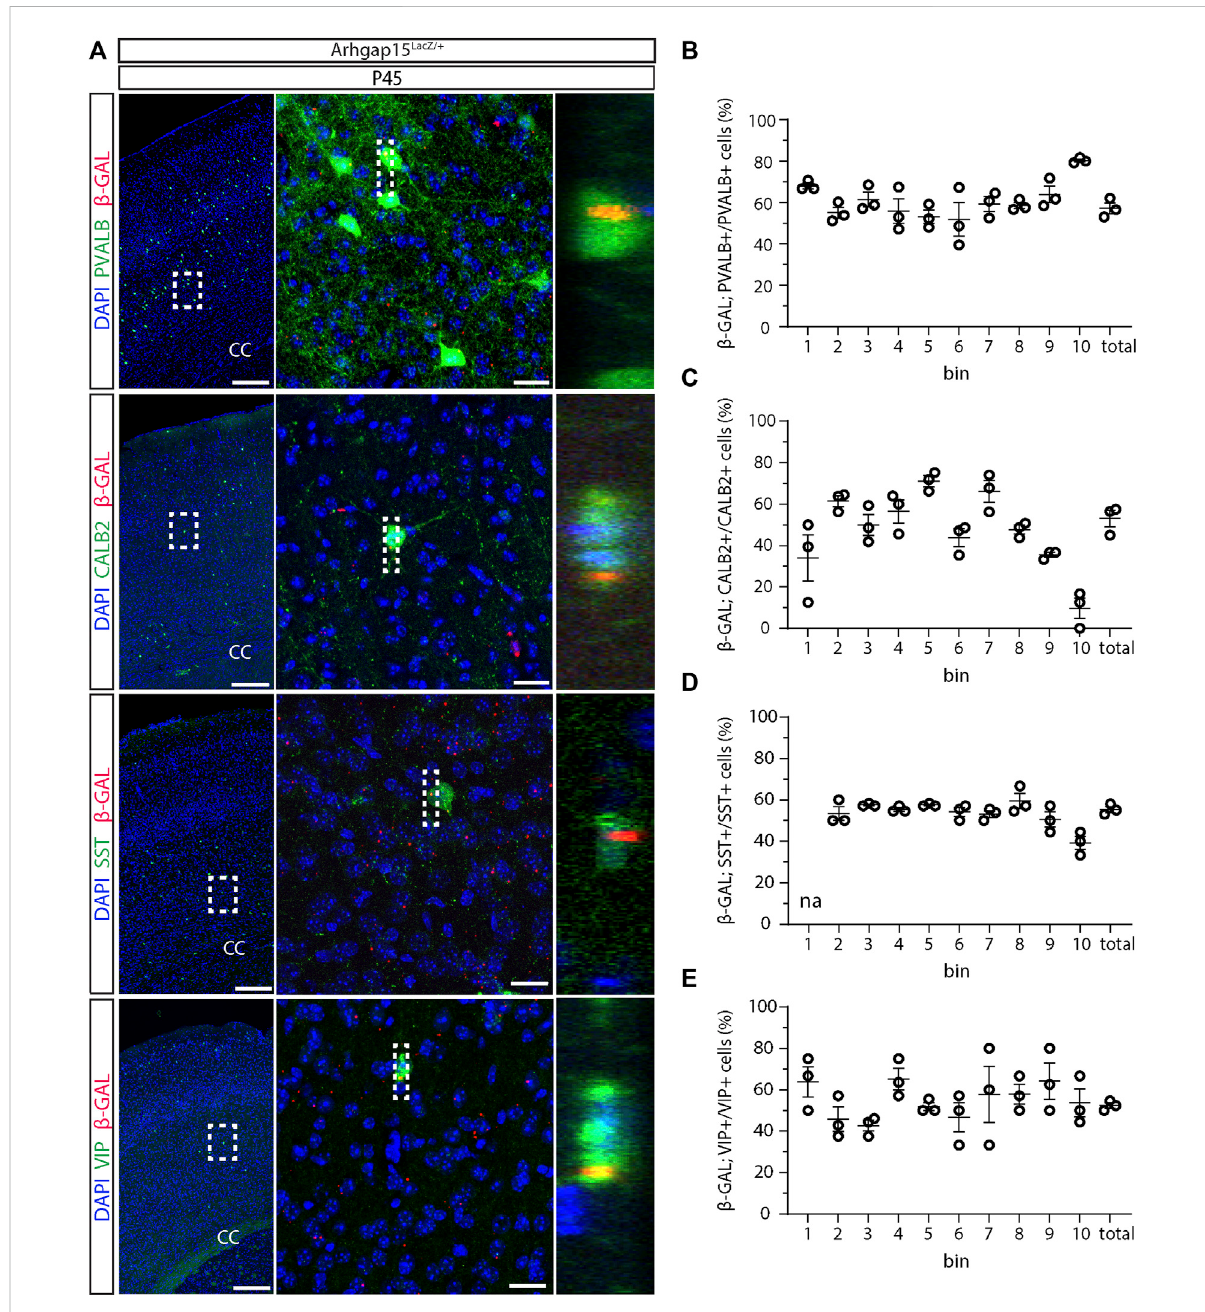
FIGURE 2 Expression of ARHGAP15 across the major CIN subtypes. (A) In the left column, maximum intensity projections of z-stack images (10 serial image planes; z step size = 2 µm) of the somatosensory cortex of P45 Arhgap15 LacZ/+ ; GAD67-eGFP brains immunostained for β -GAL and PVALB, CALB2, SST, or VIP. In the central column, maximum intensity projections of z-stack images (10 serial image planes; z step size = 0.5 µm) of the regions inside the dashed boxes on the left. In the right column, orthogonal projections of the regions inside the dashed boxes in the middle showing the co-localization of the PVALB, CALB2, SST, or VIP and the β -GAL signals. Scale bars: 200 µm (left), 20 µm (middle). (B – E) Percentage of β -GAL/PVALB (B) , β -GAL/CALB2 (C) , β -GAL/SST (D) , and β -GAL/VIP (E) double-positive cells over the total of PVALB, CALB2, SST, and VIP-positive cells, respectively. n = 3 mice; about 120 cells were evaluated for β -GAL expression for each bin in each brain. Data are presented as mean ±